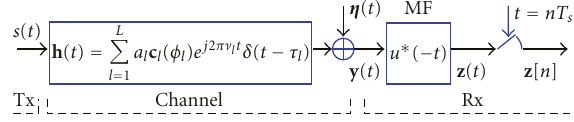
Figure 1: An equivalent baseband model of the radio channel with receiver matched filter (MF)